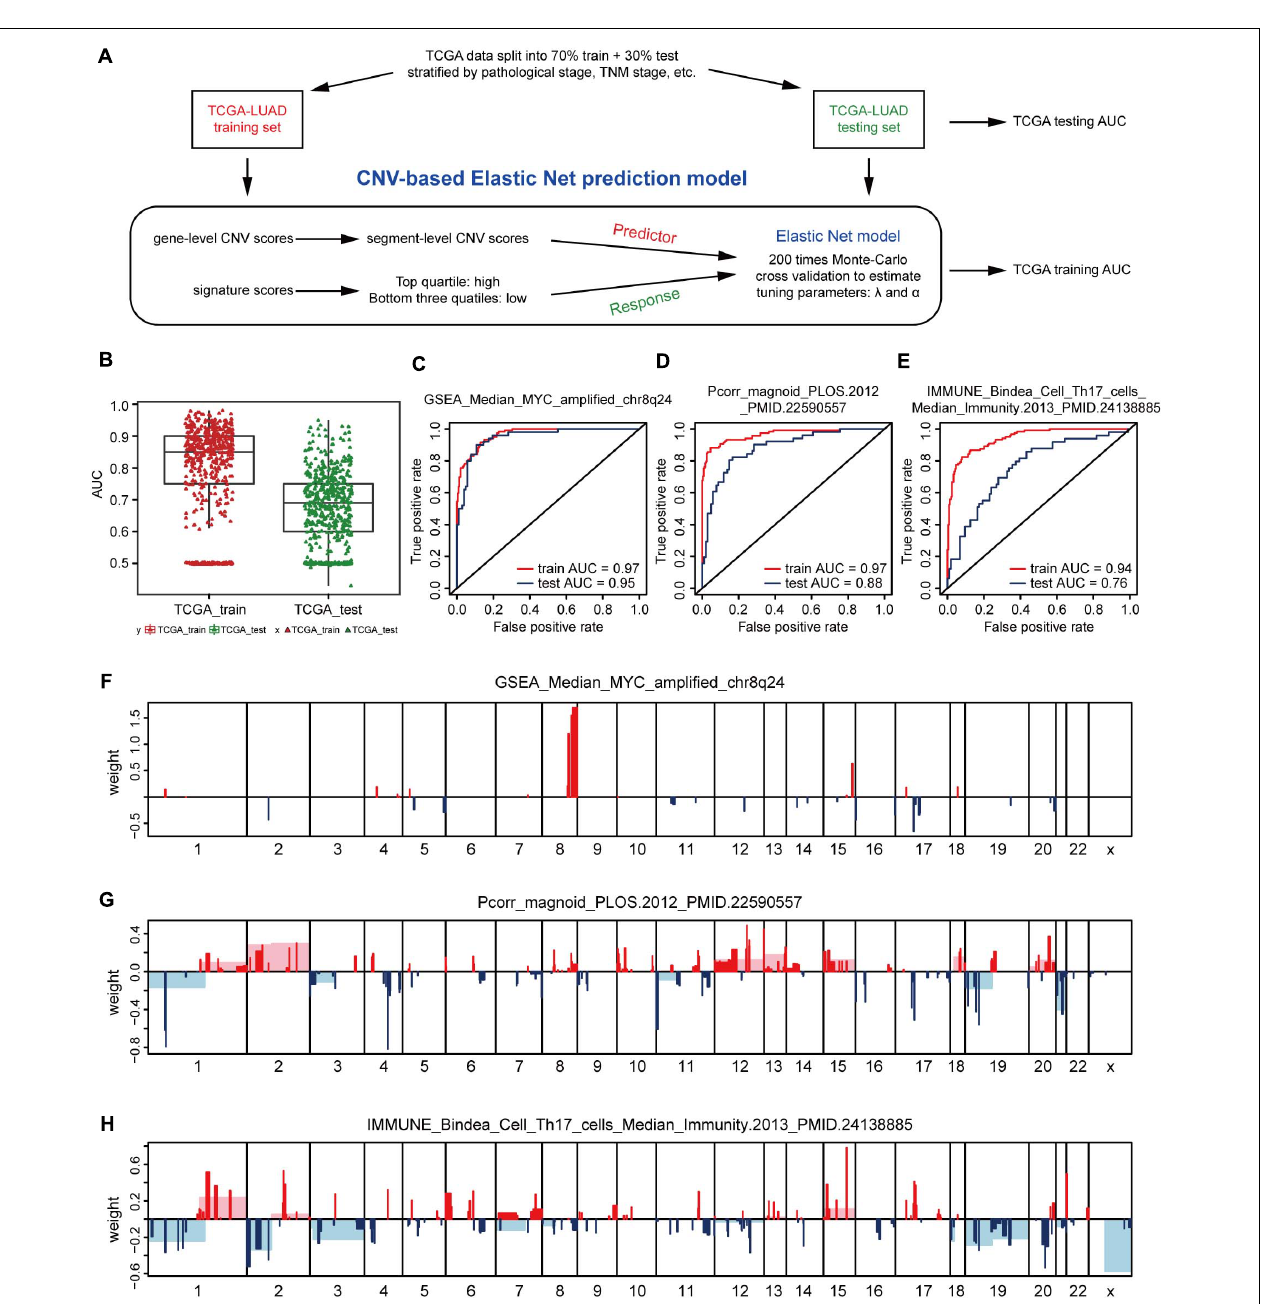
FIGURE 2 | CNV-based gene signature prediction. (A) Schematic overview of the strategy used to build Elastic Net regression models for predicting gene expression signature levels. (B) AUC distributions of CNV-based prediction for the 531 gene signature scores of lung adenocarcinoma in the TCGA training and test set. (C–E) ROC curves and corresponding AUC values for three signatures in the training and test sets. GSEA_Median_MYC_amplified_chr8q24 (C) , Pcorr_magnoid_PLOS.2012 (D) , and IMMUNE_Bindea_Cell_Th17_cells_Median_Immunity.2013 (E) . (F–H) CNV segments and whole chromosomal arms and their corresponding coefficients selected by the Elastic Net prediction models for the three